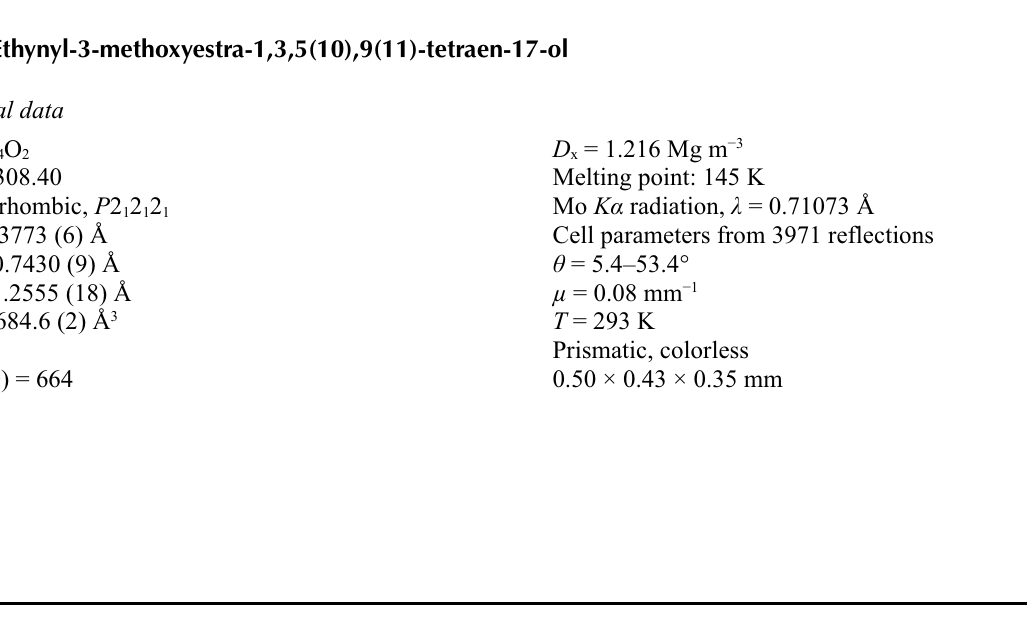
The crystal structure of the title compound, viewed along the a axis. Dashed lines indicate hydrogen bonds 17 α